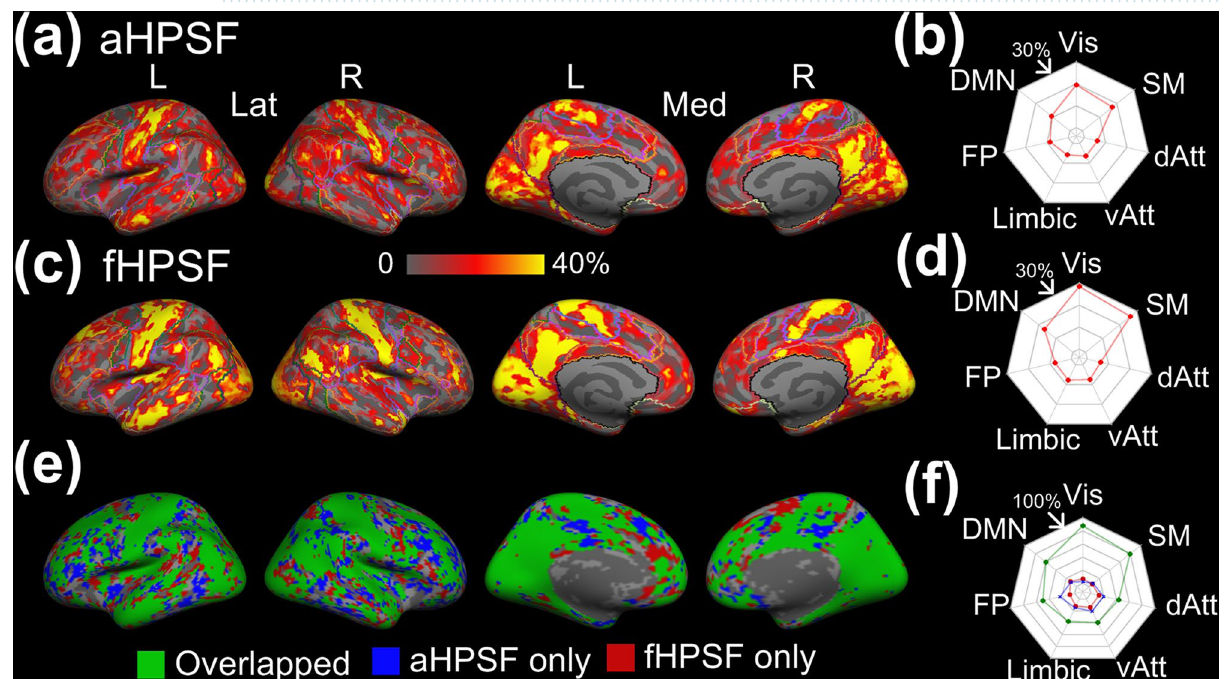
Figure 6. Hippocampal coverage of iFC associated with aHPSF and fHPSF. ( a ) The cortical map of hippocampal coverage associated with aHPSF. The contours of functional networks are outlined. ( b ) The radar chart of averaged hippocampal coverage within each functional network associated with aHPSF. ( c ) The cortical map of hippocampal coverage associated with fHPSF. ( d ) The radar chart of averaged hippocampal coverage within each functional network associated with fHPSF. ( e ) The overlap between the binarized cortical maps in ( a ) and in ( b ). The overlapping area is highlighted in green. The area which connects only with aHPSF is highlighted in blue; fHPSF in red ( f ) The percentages of the overlapping, ‘aHPSF only’ and ‘fHPSF only’ area within each functional network. L left; R right; Lat lateral view; Med medial view; Vis visual network; SM sensorimotor network; dAtt dorsal attention network; vAtt ventral attention network; Limbic limbic network; FP frontoparietal network; DMN default-mode